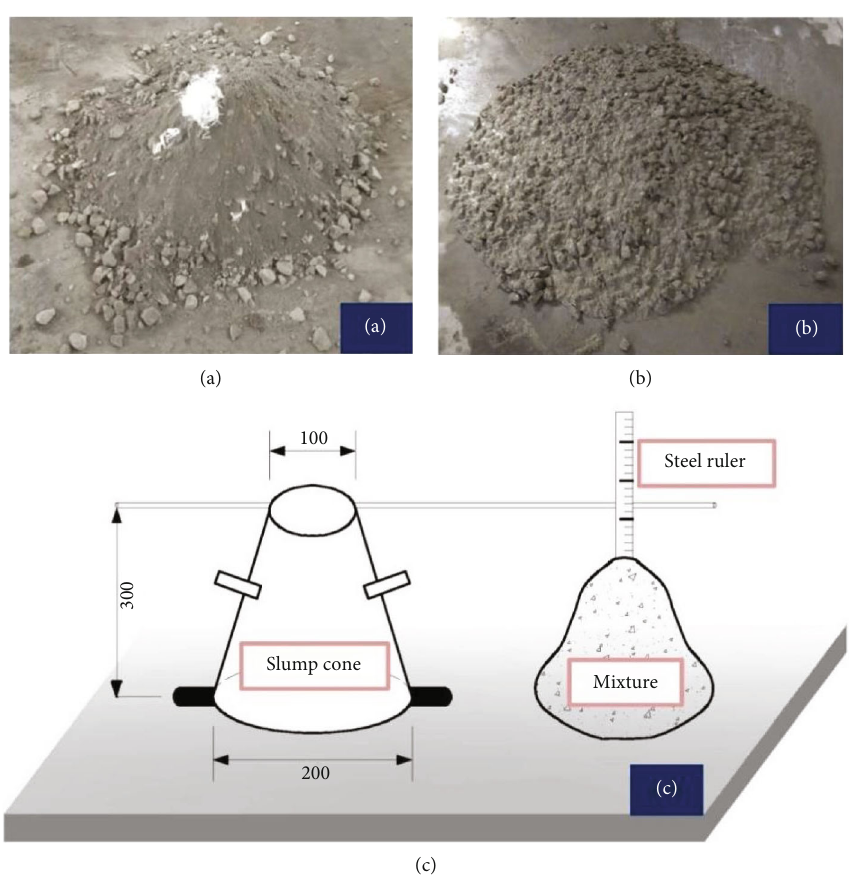
Figure 4: Concrete mixture and geometric diagram of slump cone. Table 4: Properties of PC, PPFRC-0.6, PPFRC-0.9, PPFRC-1.2, and